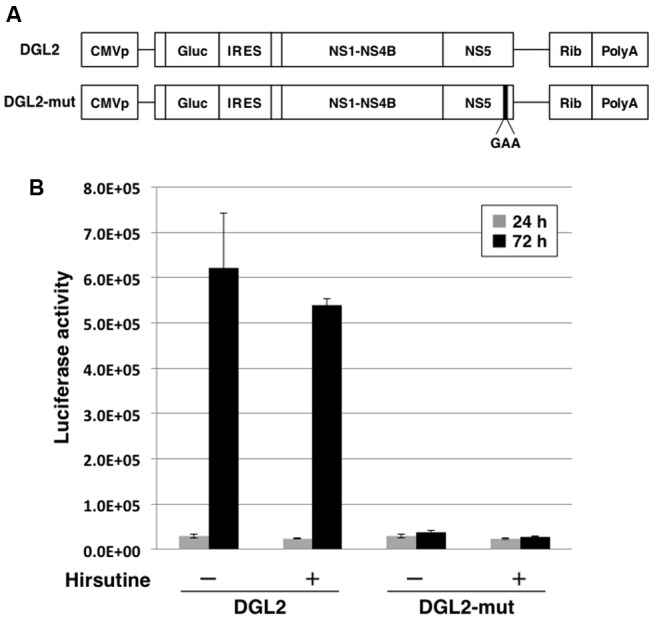
Hirsutine does not inhibit subgenomic reporter replicon activity. (A) Schematic representation of the replicon system, which uses DGL2 and DGL2-mut. DGL2-mut was inserted in non-replicative mutation into RNA-dependent RNA polymerase (RdRp). CMVp, cytomegalovirus promoter; Gluc, secretory Gaussia luciferase; IRES, internal ribosome entry site; GAA, mutation in the active center for RdRp; and Rib, ribozyme sequence. (B) Replicon plasmids DGL2 and DGL2-mut were transfected to A549 cells in the presence of 10 μM hirsutine. After 24 and 72 h, luciferase activity in the culture supernatant was analyzed. Each data point represents the mean ± standard deviation from triplicate experiments.